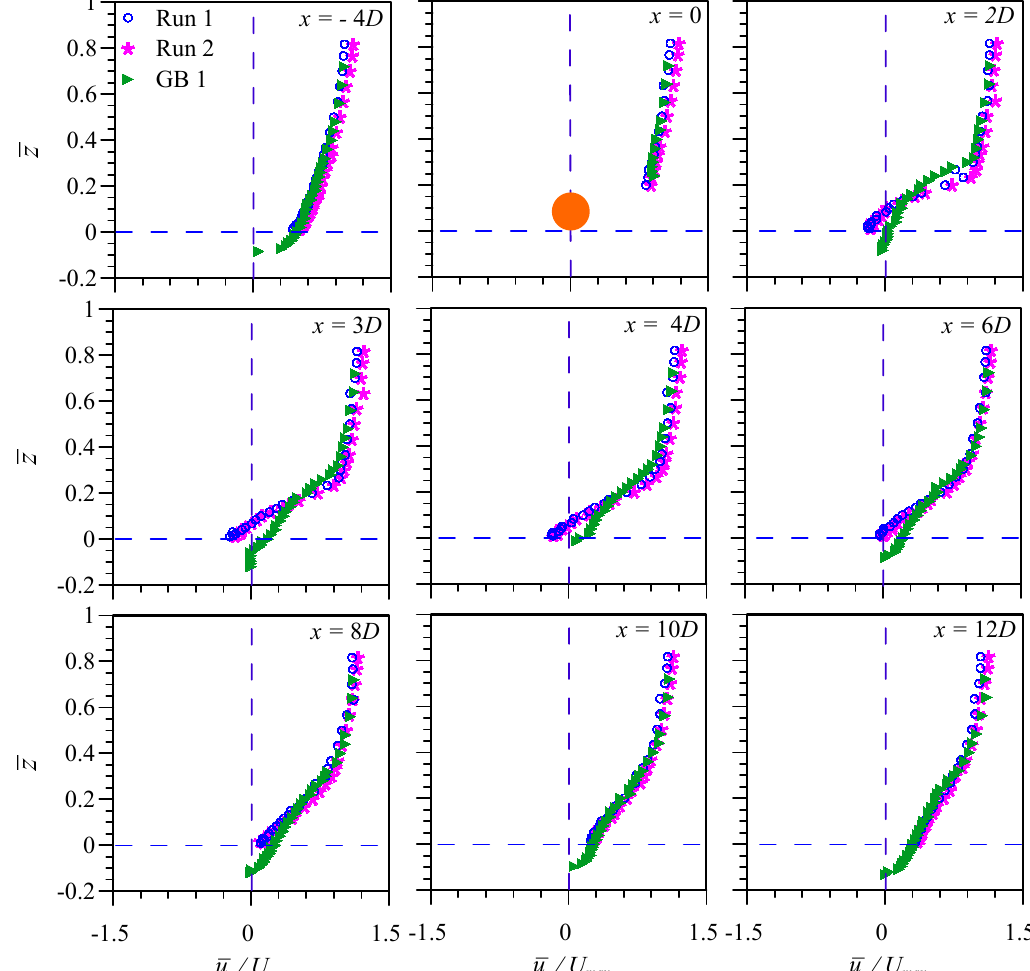
Figure 6. The vertical profiles of normalized time-averaged longitudinal velocity ( u / U max ) at different measuring stations ( 𝑥 ) for Run 1, Run 2, and GB 1.